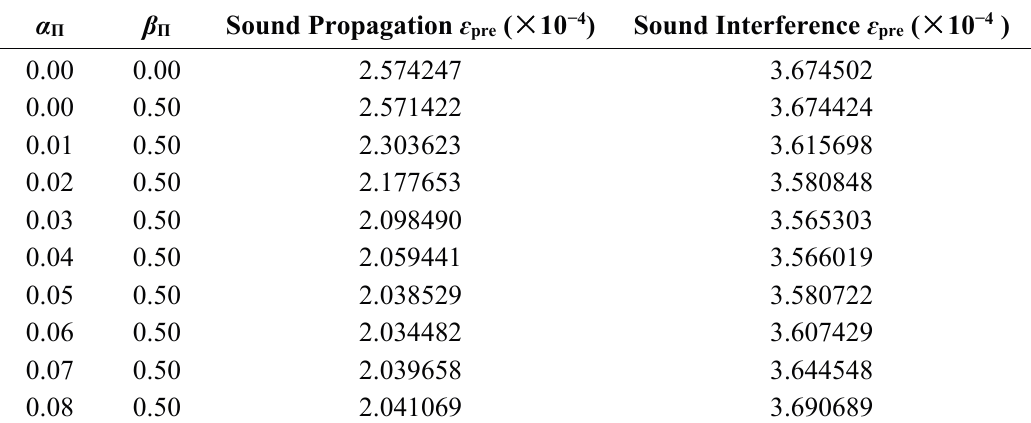
Table 2. The SPH numerical errors of sound pressure.